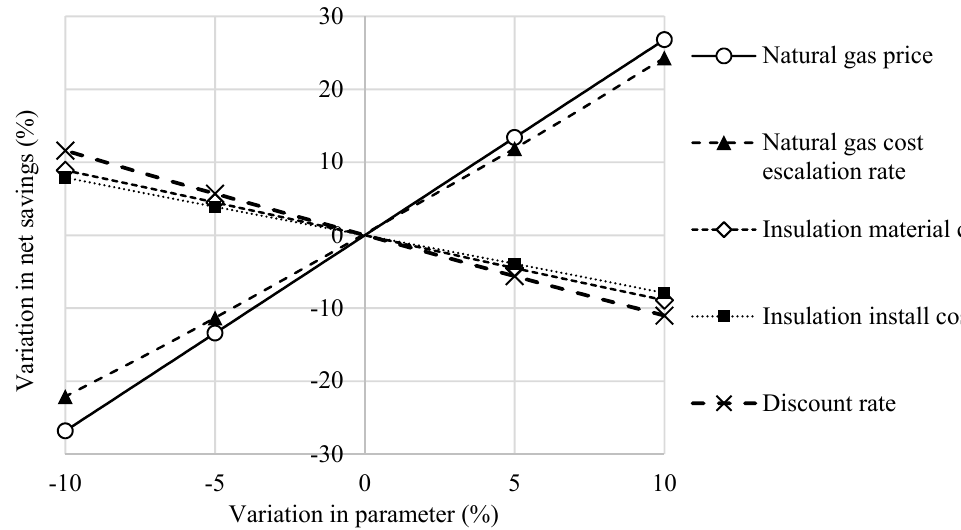
Figure 7. Sensitivity analysis for percentage change in NS given percent change in parameter— Envelope design with highest net savings for greenhouse with concrete floor.